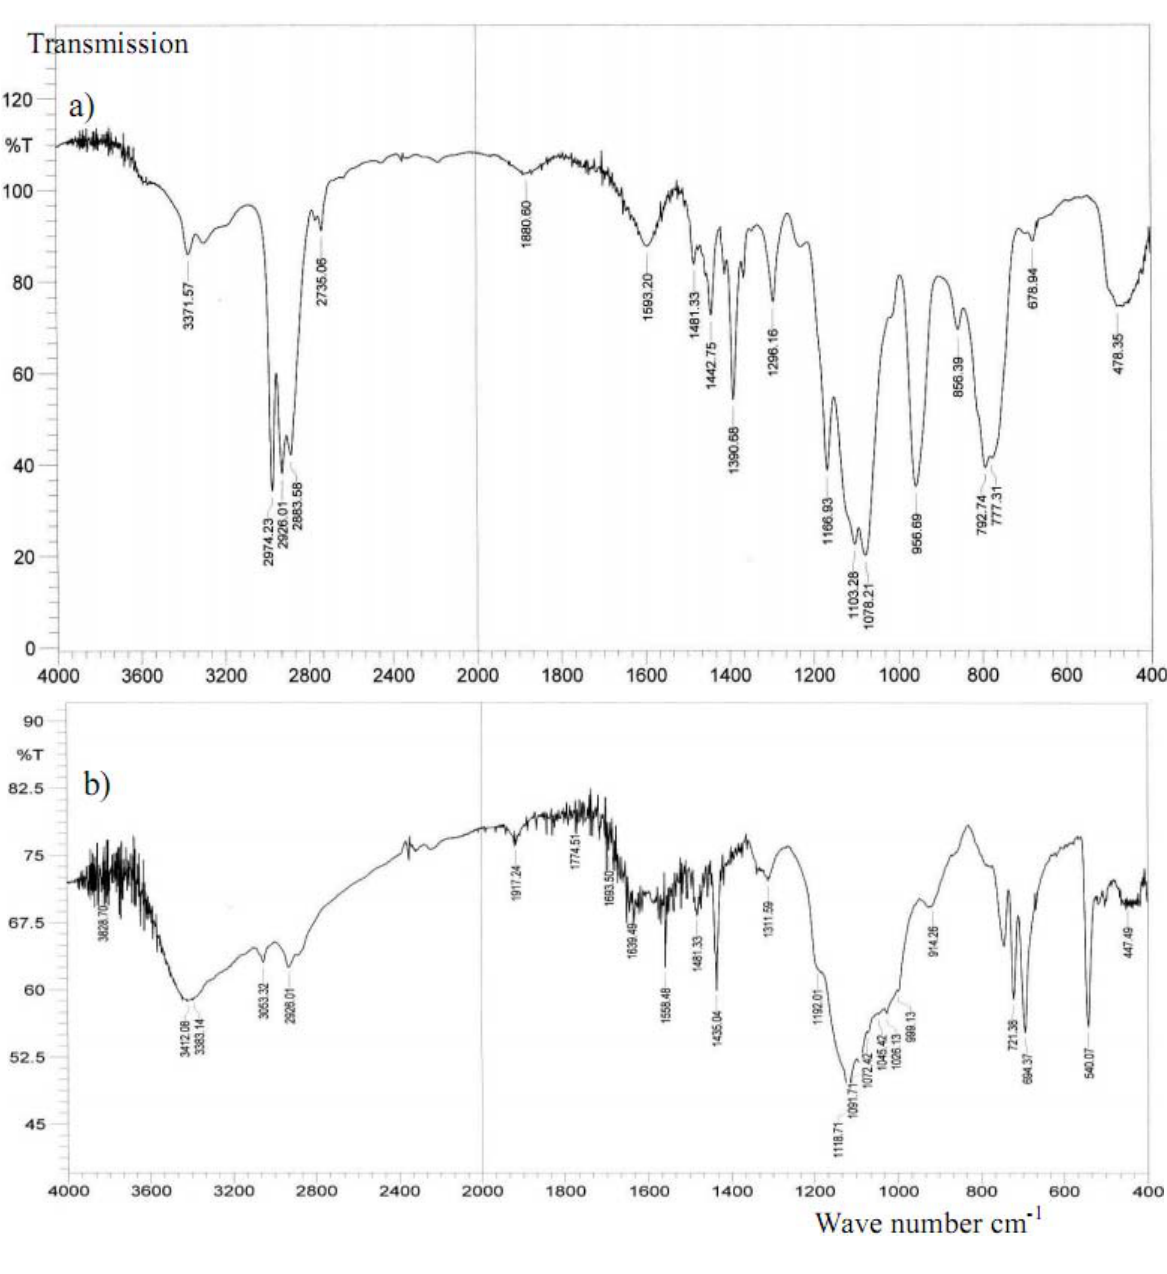
Figure 6. Infra-red spectra (a and b) of 3 and X3 , before and after sol-gel,